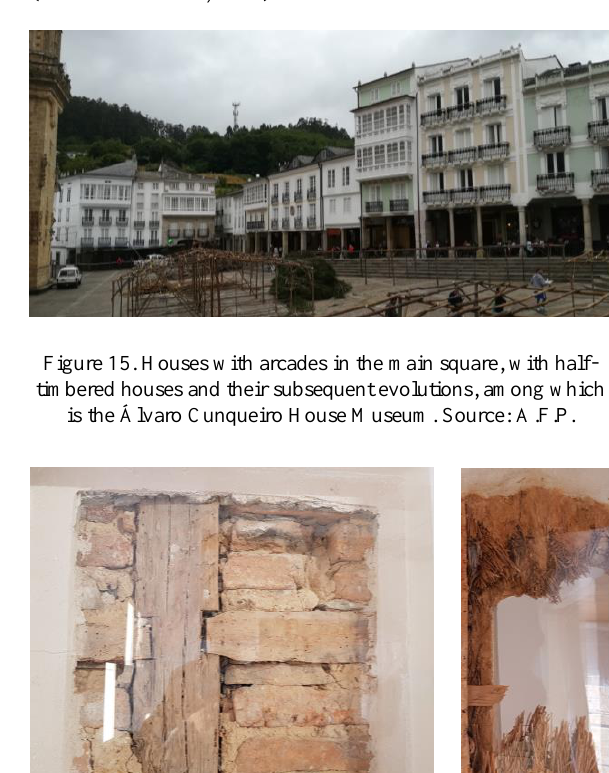
Figure 16. Details showing the half-timbered structure with the brick filling of the facade and an interior half-timbered with earth in the Álvaro Cunqueiro House Museum. The facade was made at a later time. Source: https://novacarta.eu.